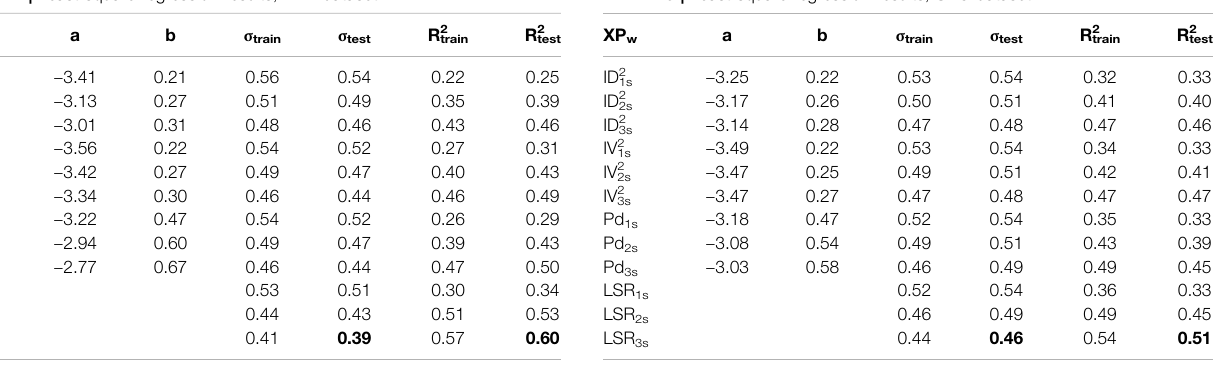
TABLE 2 | Least square regression results, ANX dataset. TABLE 3 | Least square regression results, SRC